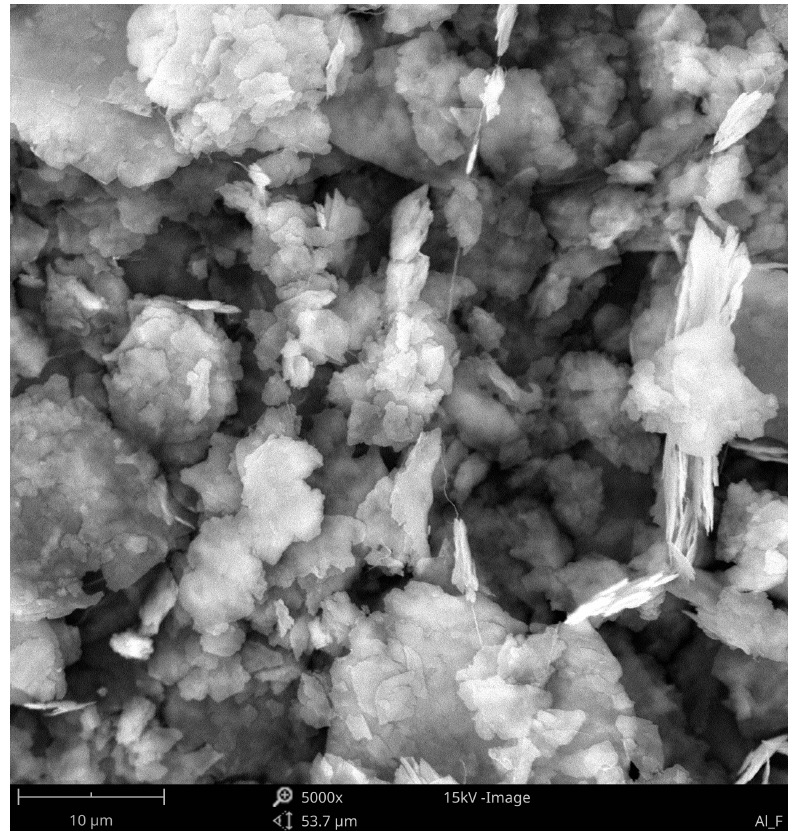
Figure A1. SEM micrograph of flaked aluminium used in this